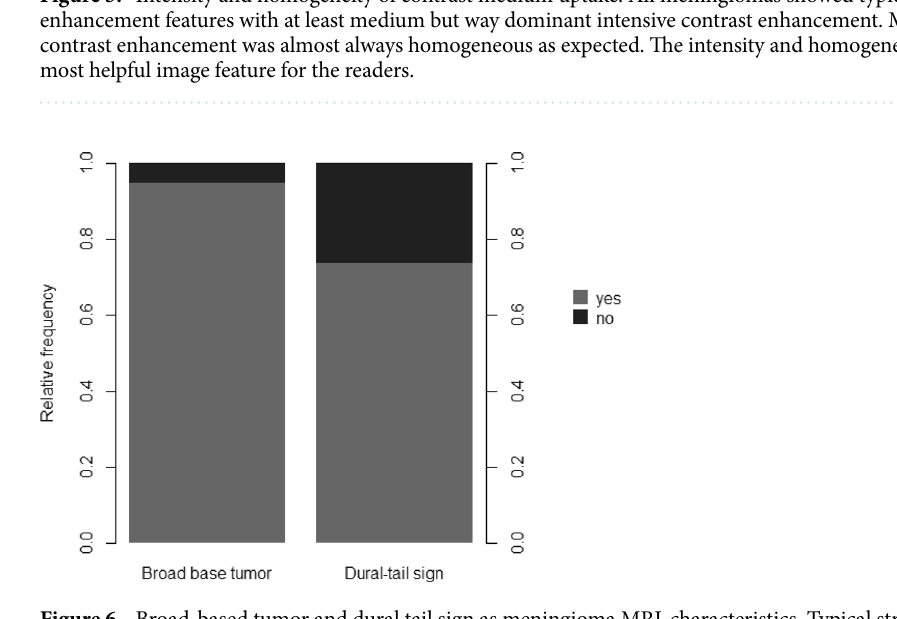
Figure 6. Broad-based tumor and dural tail sign as meningioma MRI-characteristics. Typical structural aspects for meningioma were mainly and easily identified based dural tail sign and its broad base. Other features such as hypointensity in T1 or hyperintensity in T2 to grey matter or calcifications were less often.